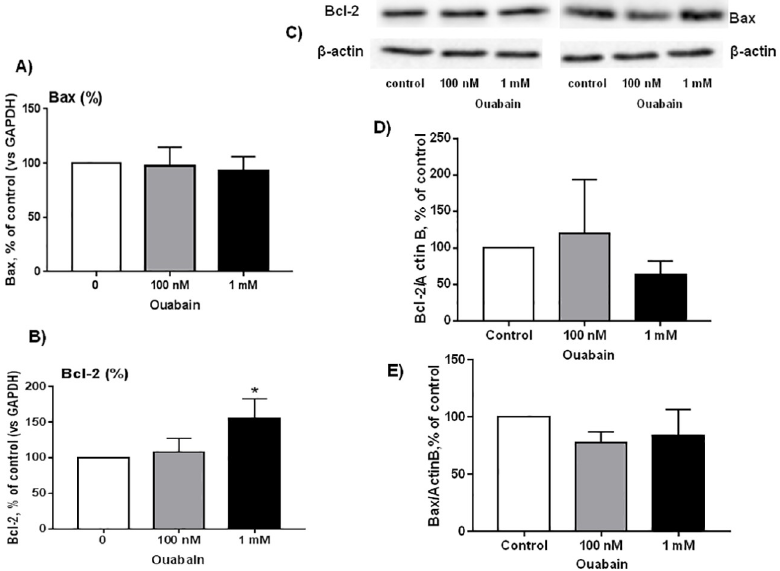
Fig 2. Effect of ouabain on content Bcl-2 and Bax mRNAs (A,B) and protein (C-E) in rat cerebellum granule cells. Cerebellum granule cells were incubated in the absence or presence 100 nM and 1 mM ouabain for 3 h. Bcl-2/GAPDH ( A ) and Bax/GAPDH ( B ) ratios in the absence of ouabain were taken as 100%. Representative Western blot ( C ) and Bcl-2/Actin B ( D ) and Bax/Actin B ( E ) ratio. Bcl-2/Actin B and Bax/Actin B ratios in the absence of ouabain were taken as 100%. Means ± SD for 4 independent experiments are shown. � —p < 0.05.